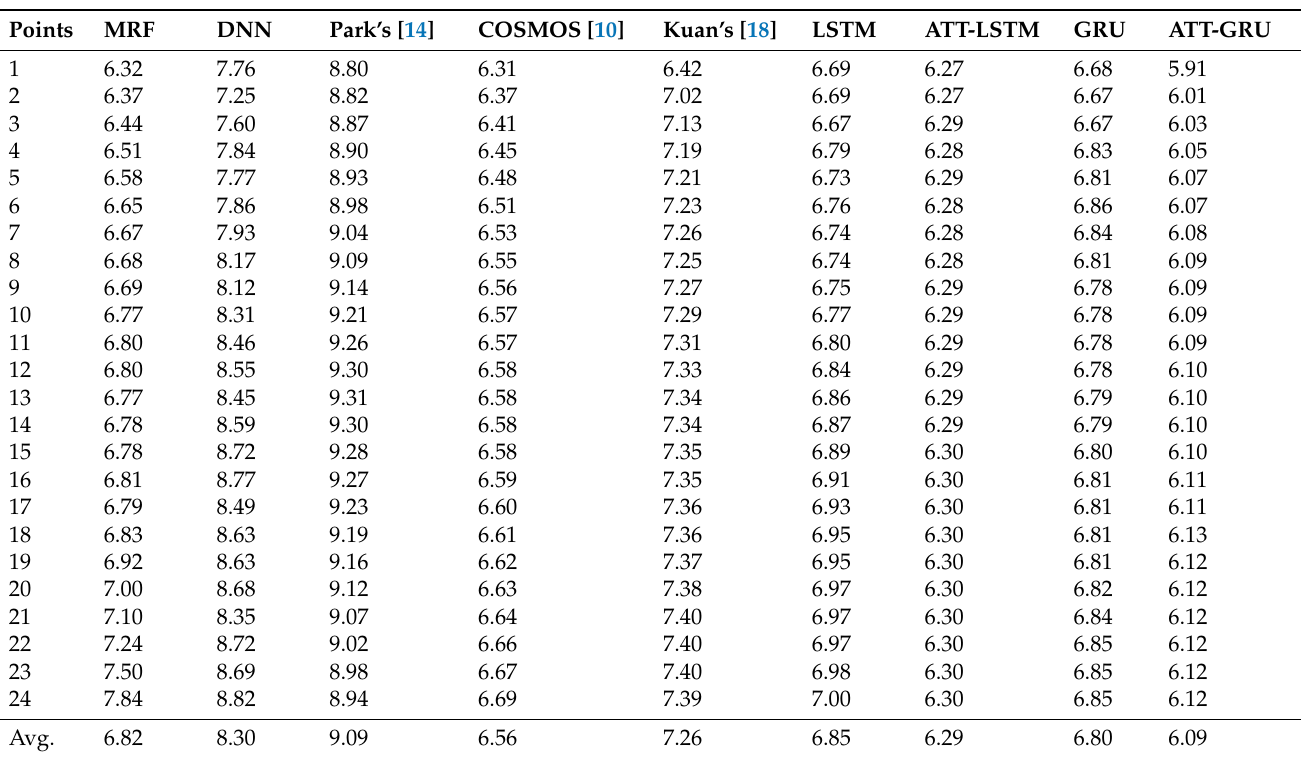
Table A3. Mean absolute percentage error comparison for Building 3.